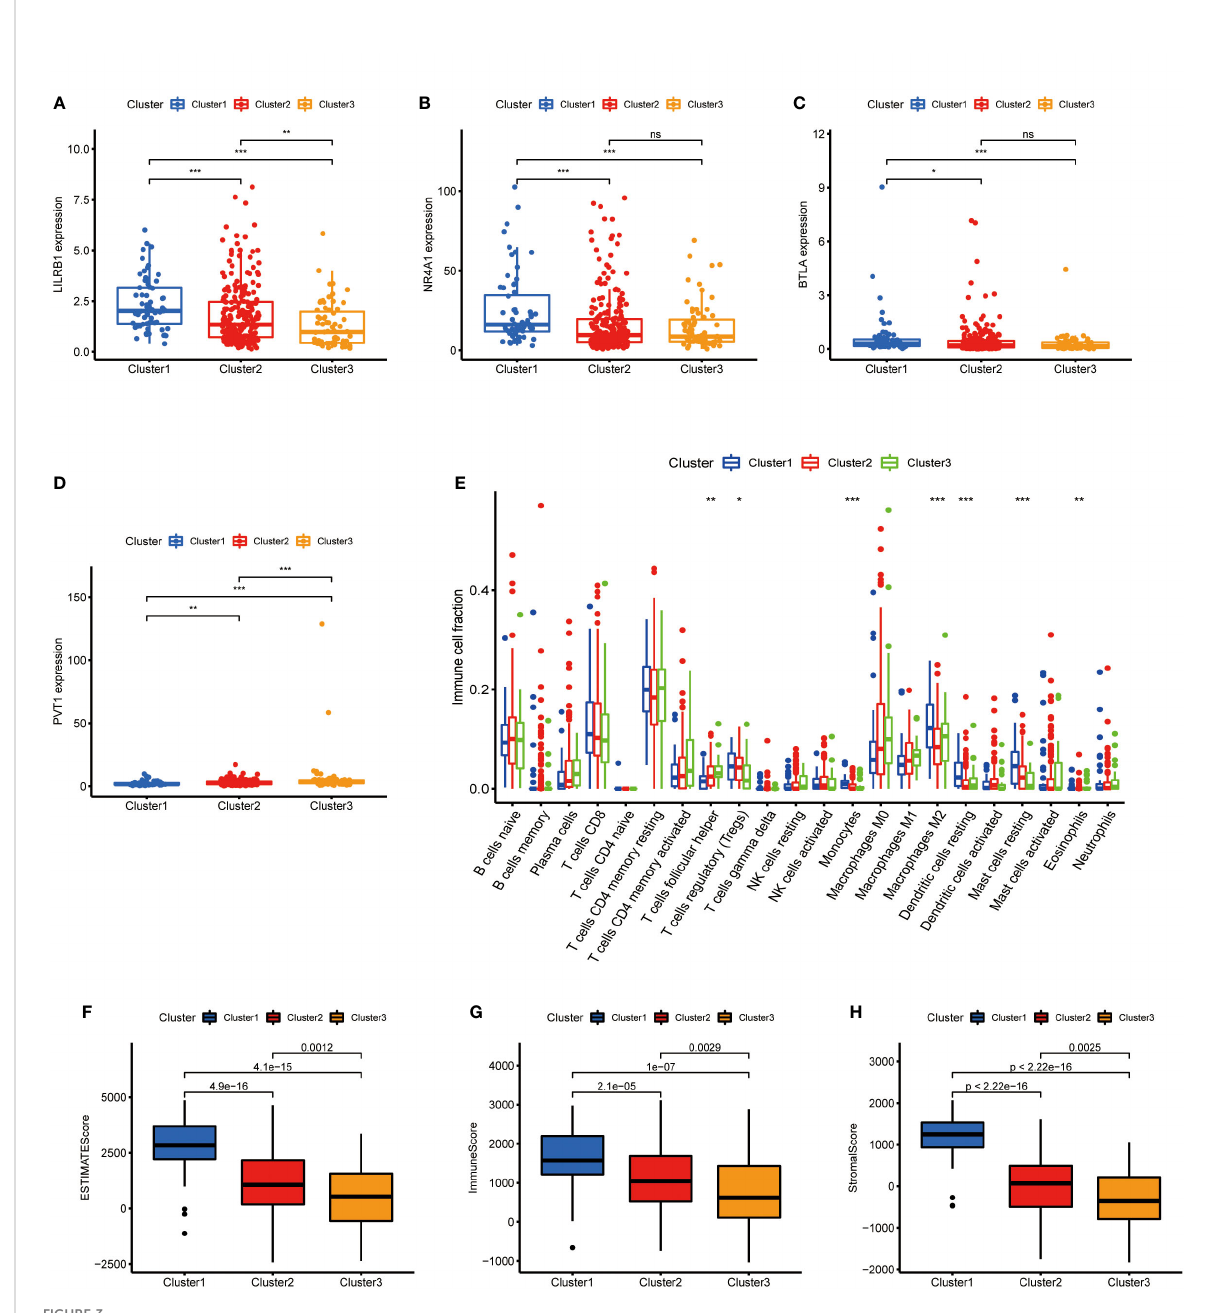
FIGURE 3 Immune cells in fi ltration of three clusters in GC. (A – D) Immune genes (LILRB1, NR4A1, BTLA) or oncogene (PVT1) expression of three clusters in GC. (E) Differences levels of in fi ltration of the 22 immune cells in three metabolic lncRNAs patterns. (F – H) The comparsion of ESTIMATEScore, ImmuneScore, and StromalScore in cluster 1, cluster 2 and cluster 3. *p<0.05,**p < 0.01 and ***p <